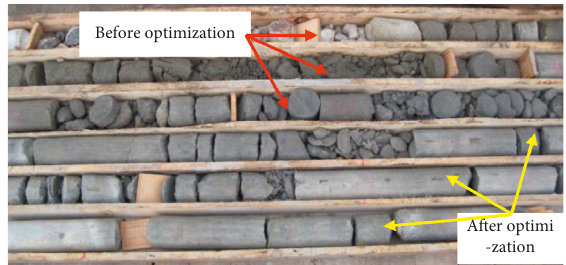
Figure 11: Comparison of backfill before and after